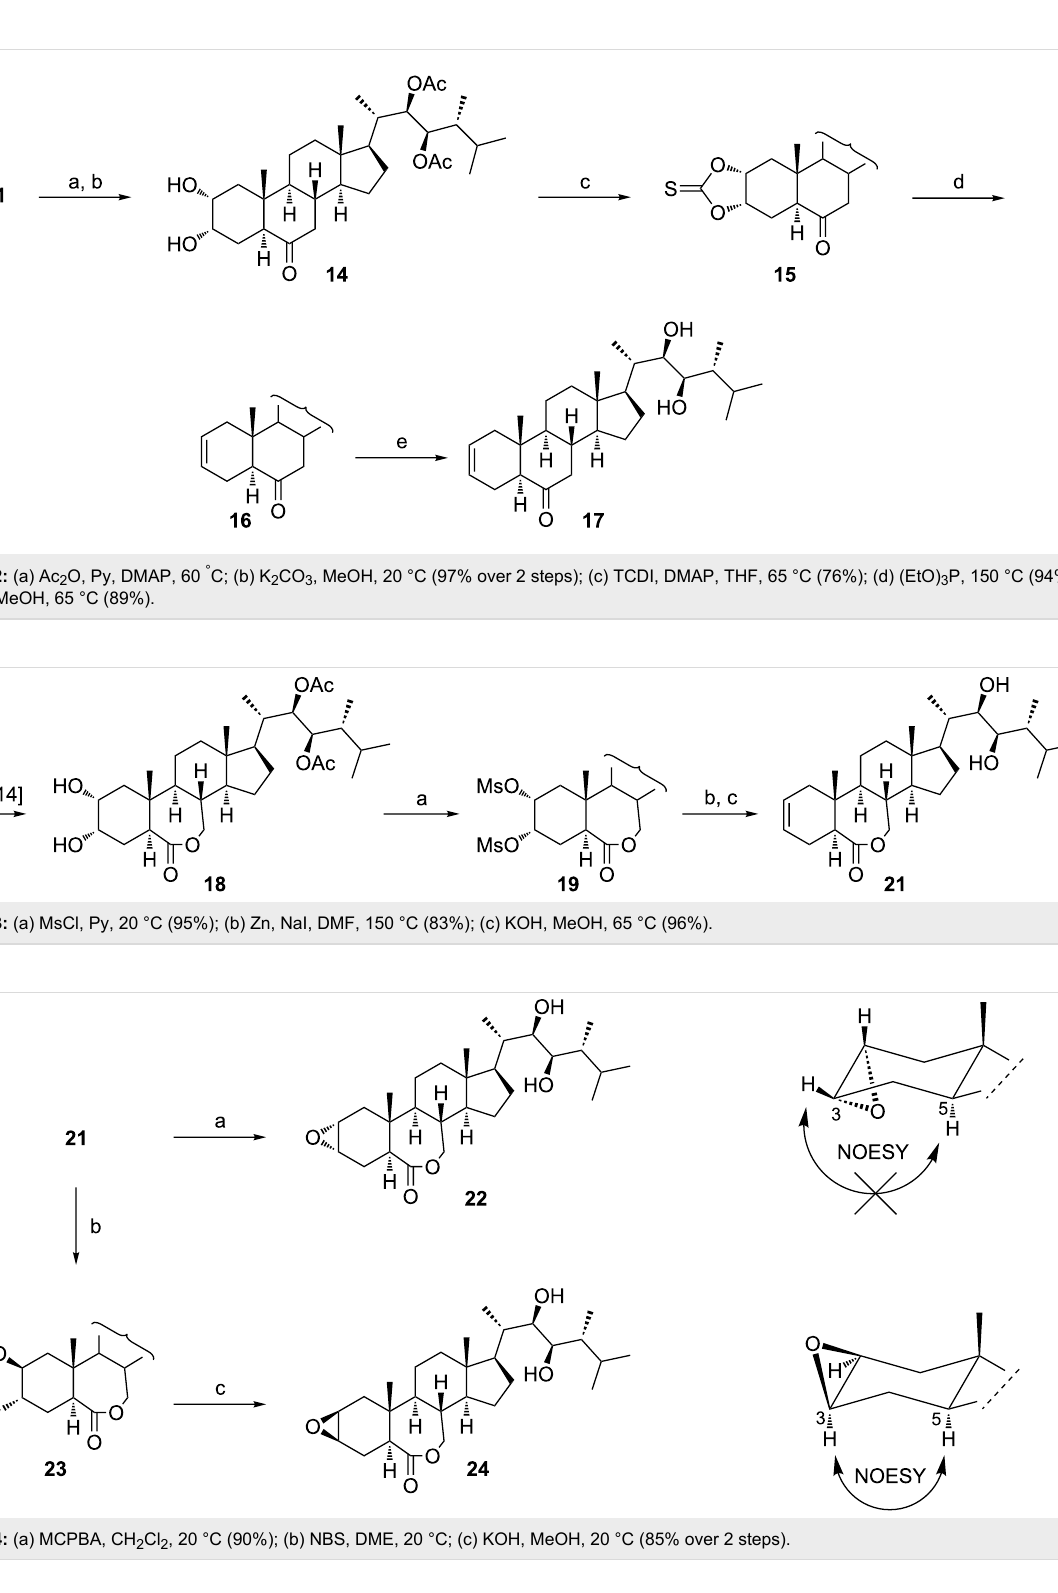
resulted in the formation of the α -epoxide 22 . The same was true for the electrophilic addition of Br + to the olefinic unit of 21 . It produced the trans-diaxial bromohydrine 23 that